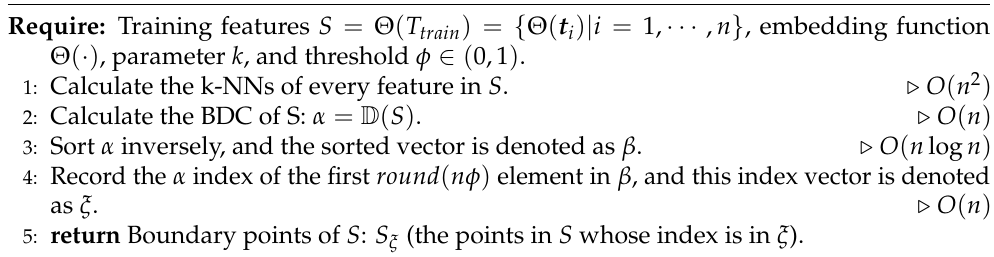
Algorithm 1 Boundary detection algorithm.